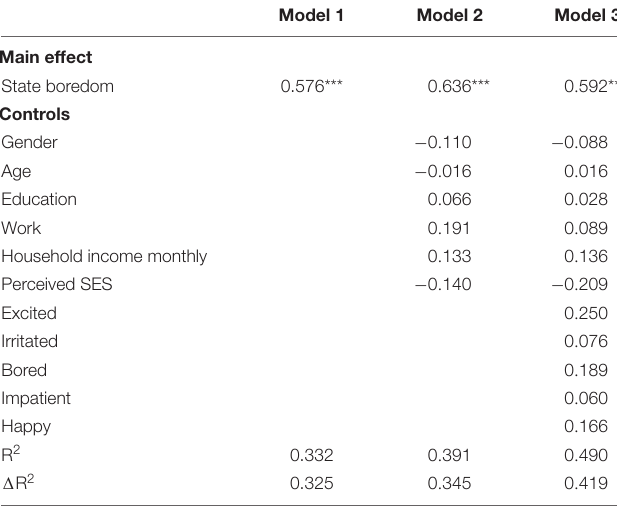
TABLE 3 | The effect of state boredom on livestreaming addiction.